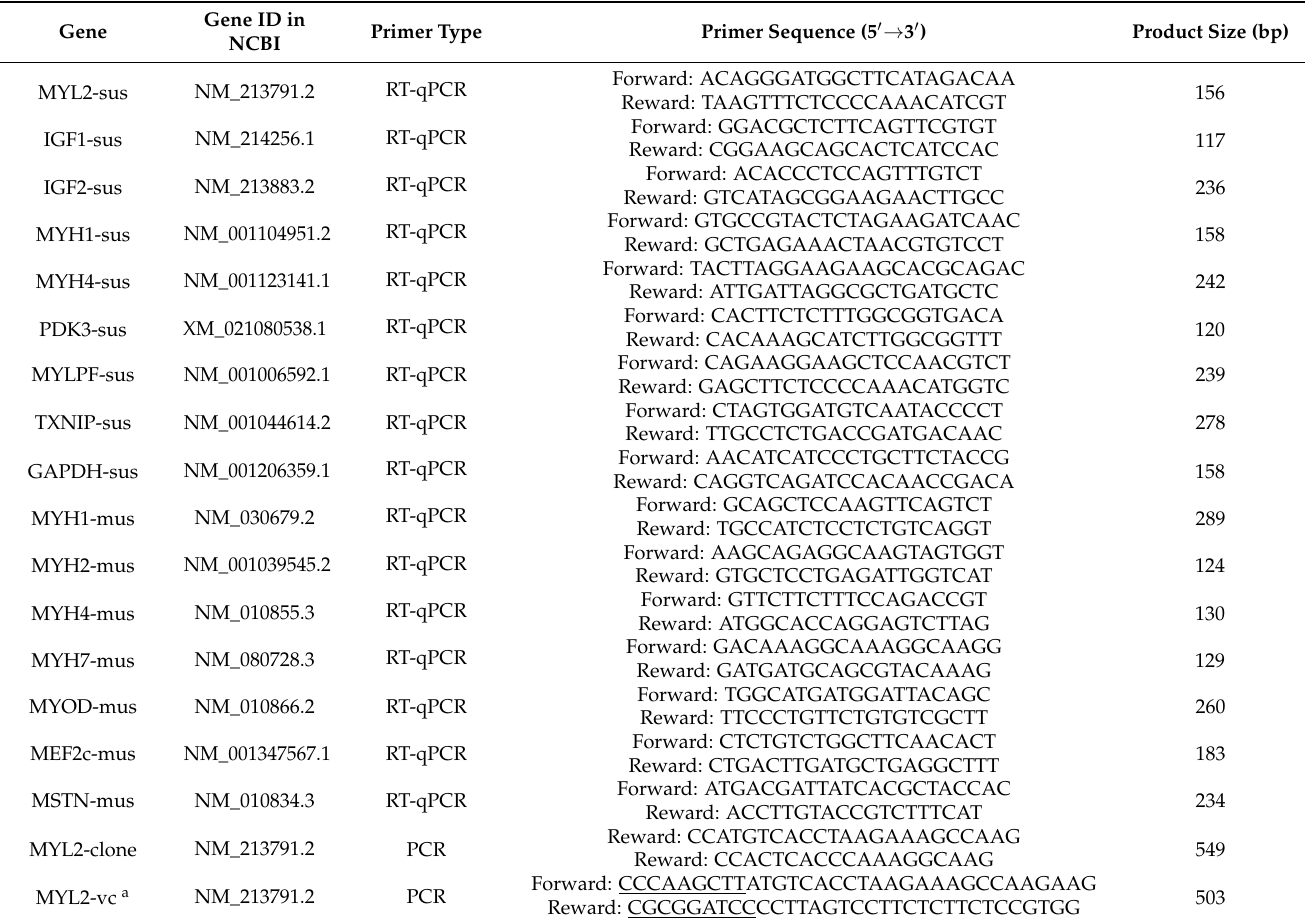
Table 1. Primer sequences for reverse transcription–quantitative PCR (RT-qPCR) and